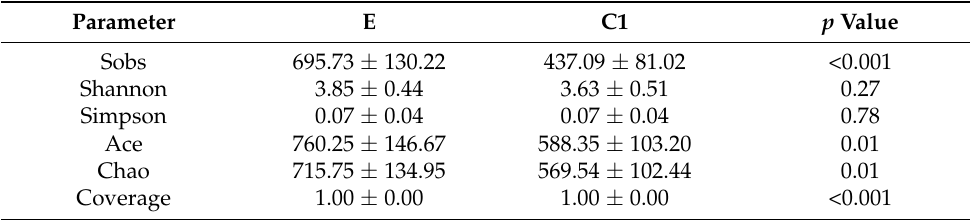
Table 2. Indexes of the intestinal flora diversity of the pre-exercise sleep—disordered Group (E) and sleep—normal Group (C1).